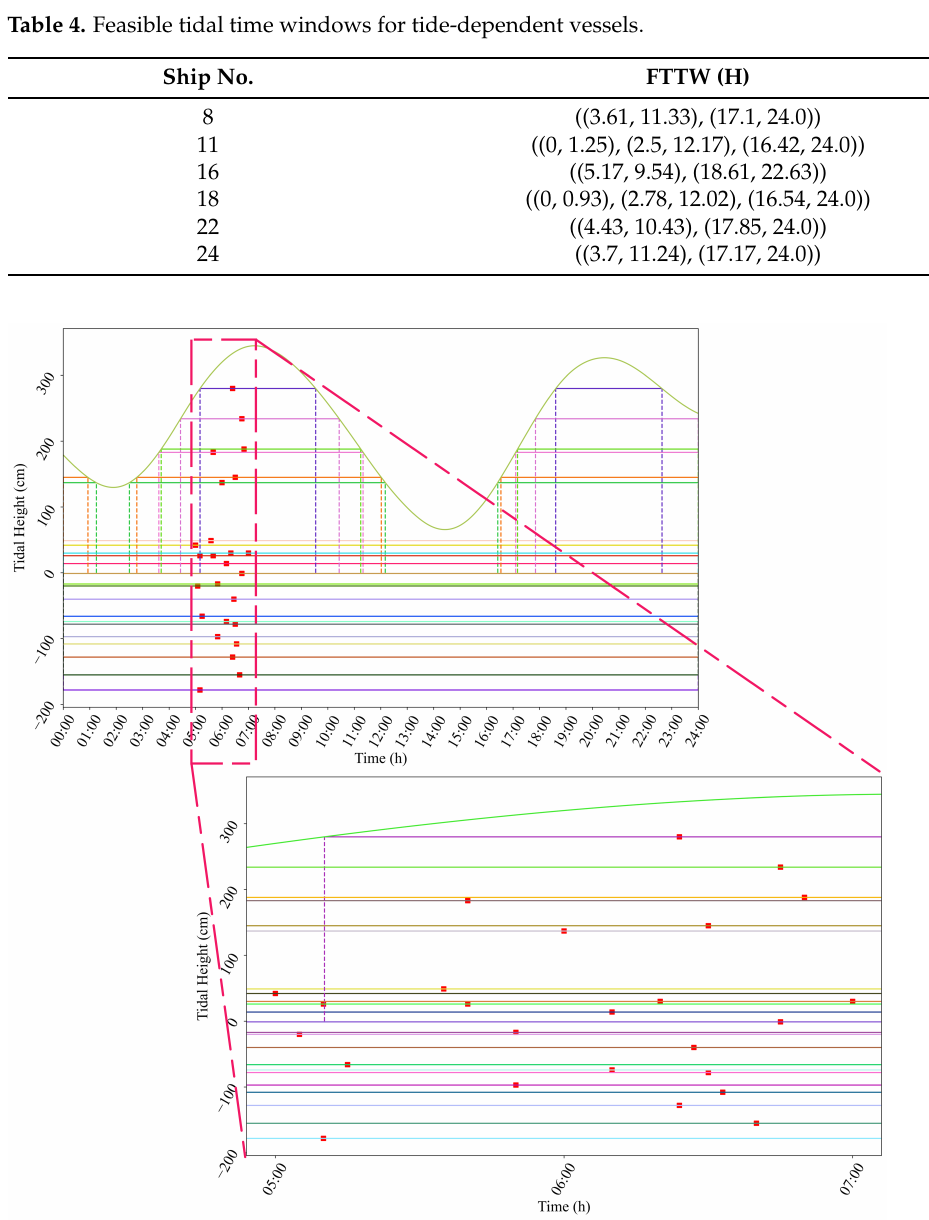
Figure 7. Feasible tidal time window for vessels. The horizon lines are vessel time windows, the vertical lines are the period, and the red points are the estimated time of